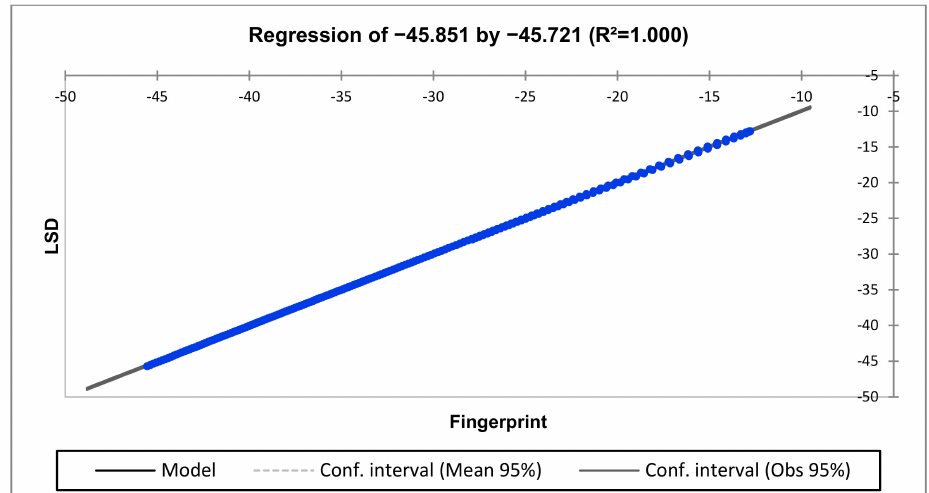
Figure 24. Regression for H3-H2 vs. H1-H3 (lower-frequency region).